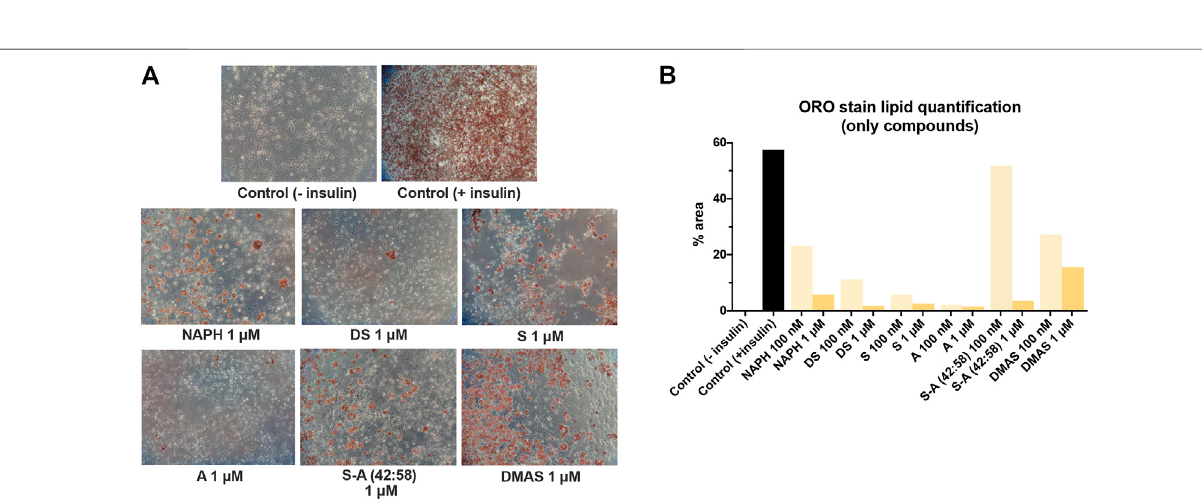
FIGURE 4 | Differentiation of 3T3-L1 cells in the presence of insulin and A/S derivatives. (A) Representative microscopic images of the stained cells for the various samples at 1 μ M. All images were recorded at ×10 magni fi cation. Control ( − insulin) and control (+insulin) represent negative and positive control samples, respectively. (B) Lipid quanti fi cation based on the amount of ORO stain present in each sample.